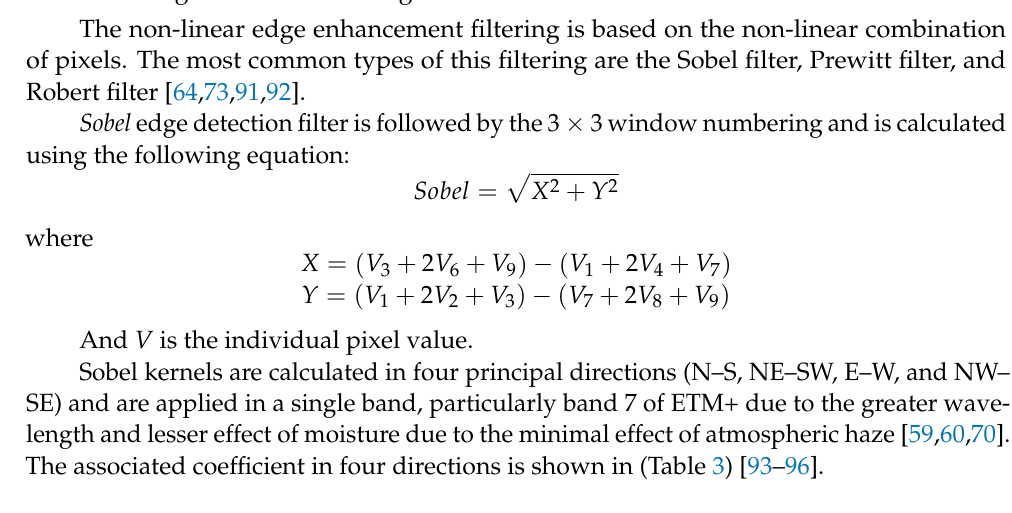
Table 3. Four direction widows for Sobel and Prewitt filters with their associated coefficient. N-S NW-SW E-W